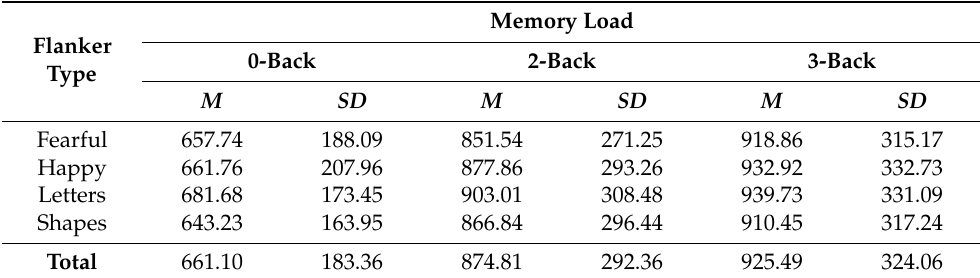
Table 6. Descriptive statistics of participants’ mean reaction times for correct rejections (before log-transformed) for Study 1.